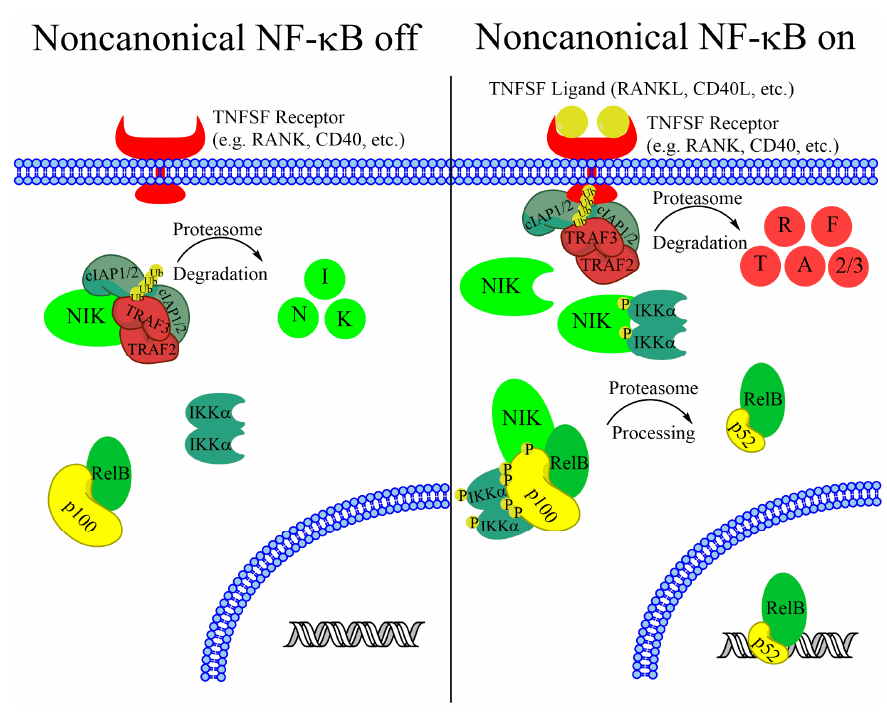
Figure 1. Overview of the Noncanonical NF- κ B signaling pathway. In the absence of a stimulus the critical kinase NIK is constitutively targeted for degradation by a ubiquitination complex containing TRAF2, TRAF3, cIAP1, and cIAP2. Upon receptor activation, NIK is stabilized, leading to IKK α activation and p100 processing to p52. RelB-p52 dimers then translocate to the nucleus and activate transcription.